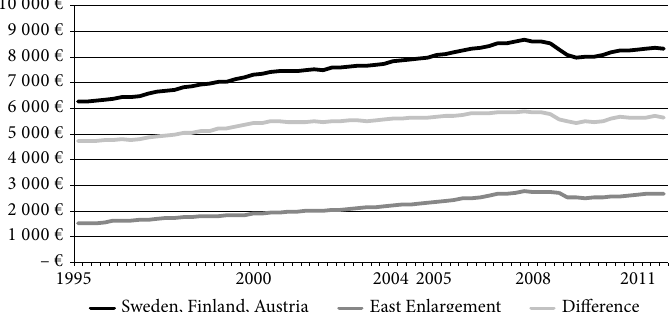
Fig. 6. Convergence in GDP per capita of EU Eastern enlargement countries vs. Spain, Greece and Portugal Source : own results.